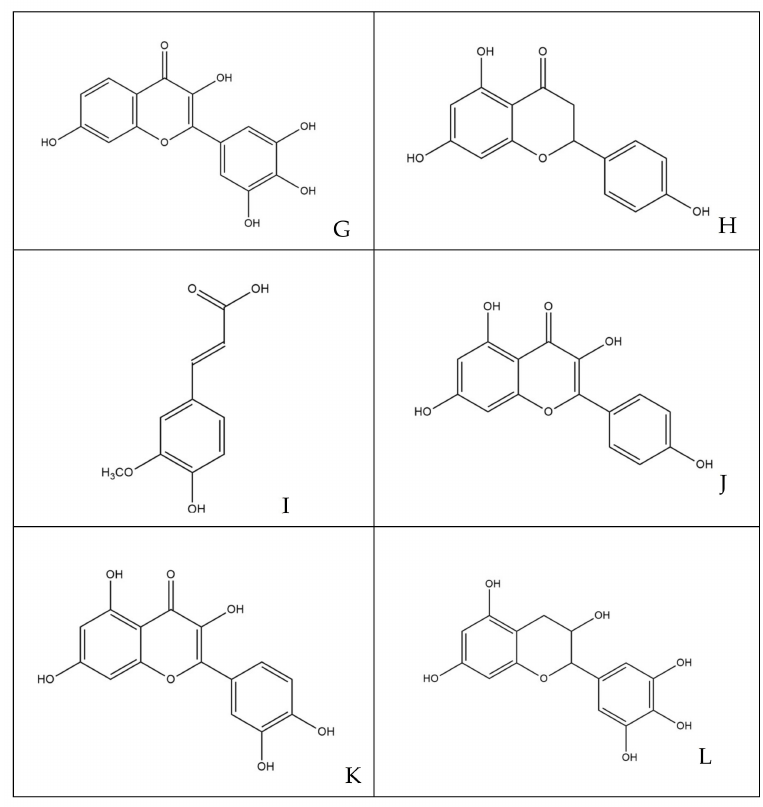
Figure 7. Structures of molecules typically found in MOE phytocomplex [14,15]: ( A ) morin; ( B ) myricetin; ( C ) luteoline; ( D ) chlorogenic acid; ( E ) ellagic acid; ( F ) rutin; ( G ) robinetin; ( H ) naringenin; ( I ) ferulic acid; ( J ) kaempferol; ( K ) quercetin; ( L )